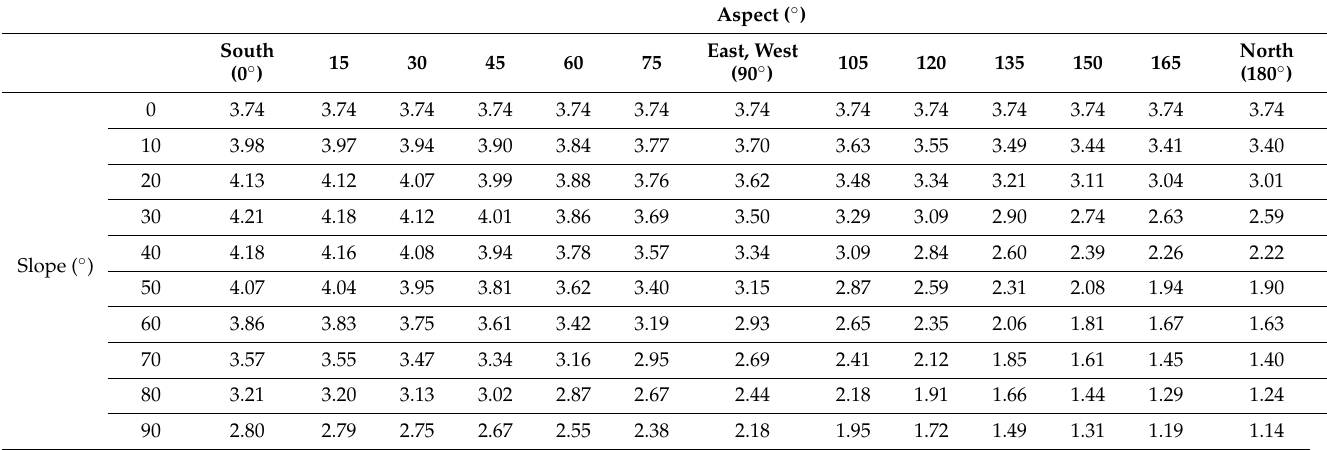
Table 2. Annual average slope solar radiation per day for Nagoya City (kWh/m 2